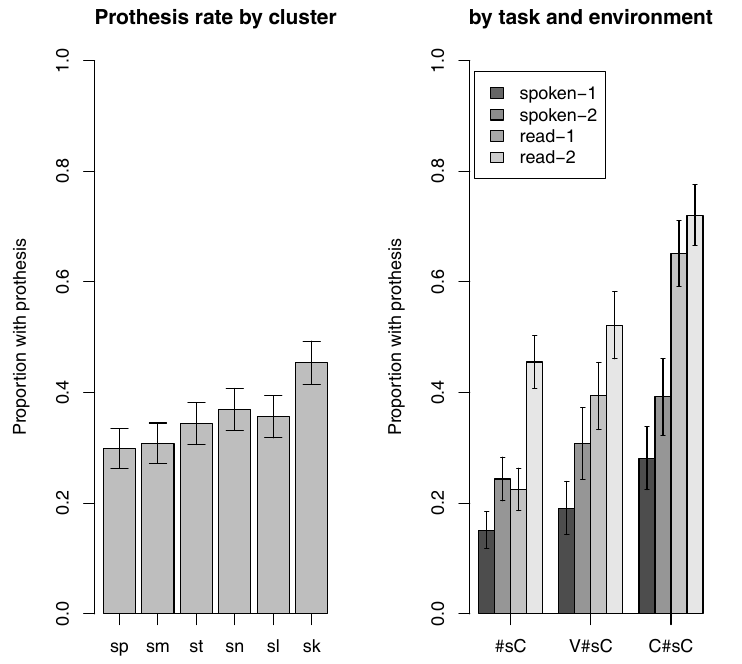
Figure 4 . Prothesis rate (a) by cluster and (b) by environment and task. Error bars represent mean standard